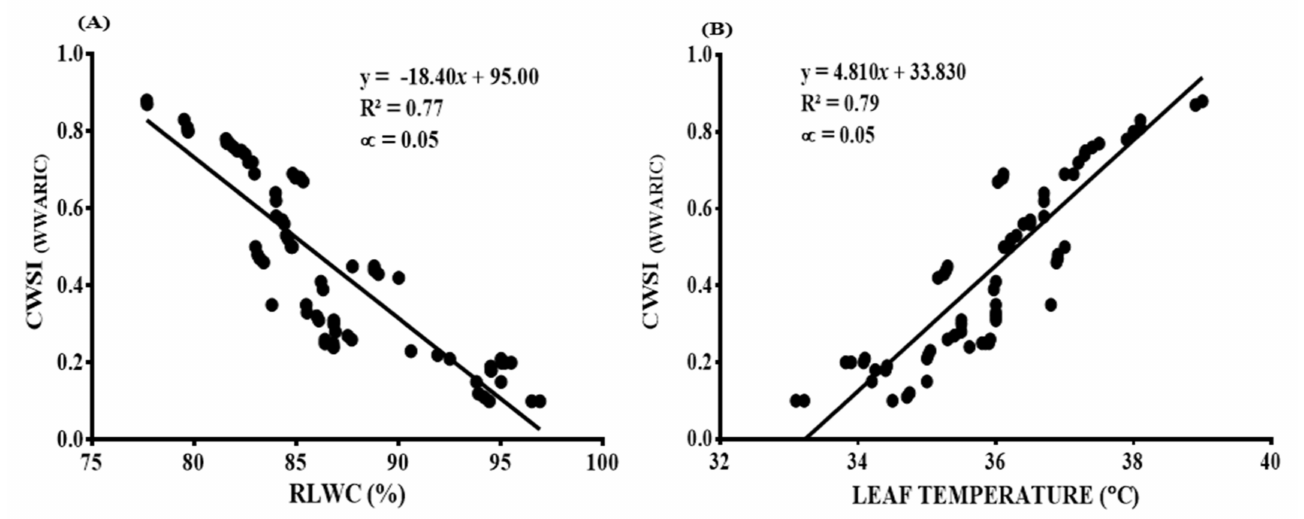
Figure 14. Correlation between ( A ) CWSI (WWARIC) and RLWC (%) and ( B ) CWSI (WWARIC) and leaf temperature ( ◦